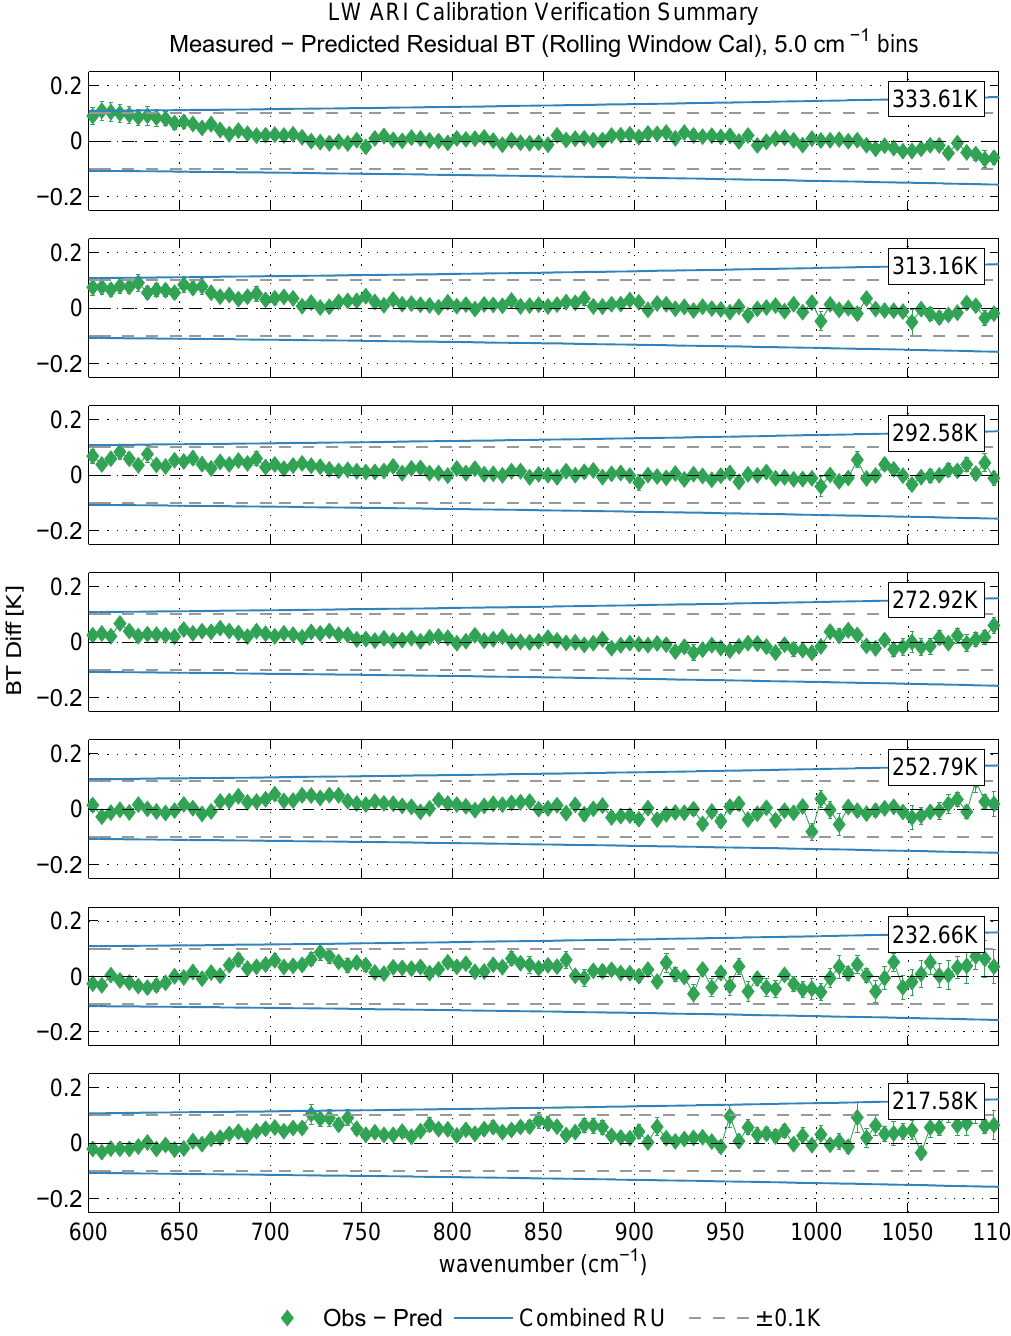
Figure 15. Long-wave MCT detector brightness temperature residuals (observed–predicted) for end-to-end calibration verification datasets conducted under vacuum. The results have been spectrally averaged in 25 cm − 1 wide bins for noise reduction. Error bars represent statistical error only (k = 1 standard error). Total (calibration and calibration verification) radiometric uncertainty (k = 3) is shown in blue, and the grey dashed lines indicate ± 0.1 K. The artifact associated with the original field stop is evident. The solution to this issue was implemented post-vacuum testing.